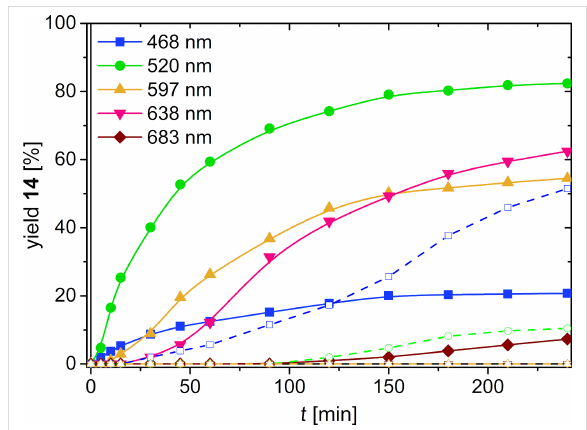
Figure 3: Kinetic analysis of yields of product 14 in the presence (solid lines) and in the absence (dashed lines) of cNDI 6 : 500 mM 12 , 250 mM 13 , 50 mM organocatalyst 15 , 500 mM 2,6-lutidine in 1.3 mL DMF, stirring, irradiation by